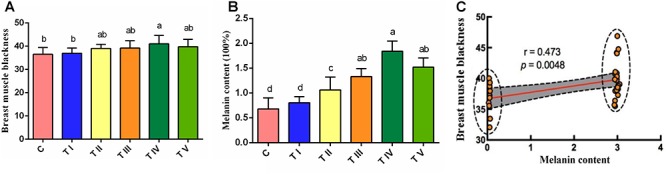
Degree of blackness and melanin content of breast muscle tissue. (A) Breast muscle blackness. (B) Melanin content of breast muscle tissue. (C) Analysis of the correlation between the melanin content and the degree of blackness of breast muscle tissue. In x-axis, the C represents the control group, and the TI-TV represents test groups I-V, respectively. Data are expressed as mean ± SD (n = 60). The small letters a, b, etc., on the top of each bar represents statistical significance. Data with different small letters on each bar are statistically significant (P < 0.05), while data with the same letters are not statistically significant (P > 0.05).